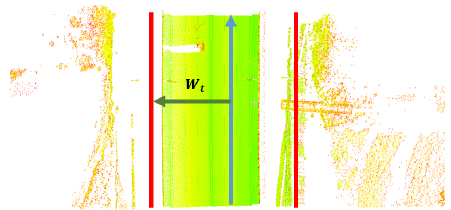
Figure 3. Preprocessing based on the trajectory. The blue arrow indicates the trajectory, and the green arrow is perpendicular to the trajectory. The points outside the red line, whose distance to the trajectory is greater than W t , will be removed.